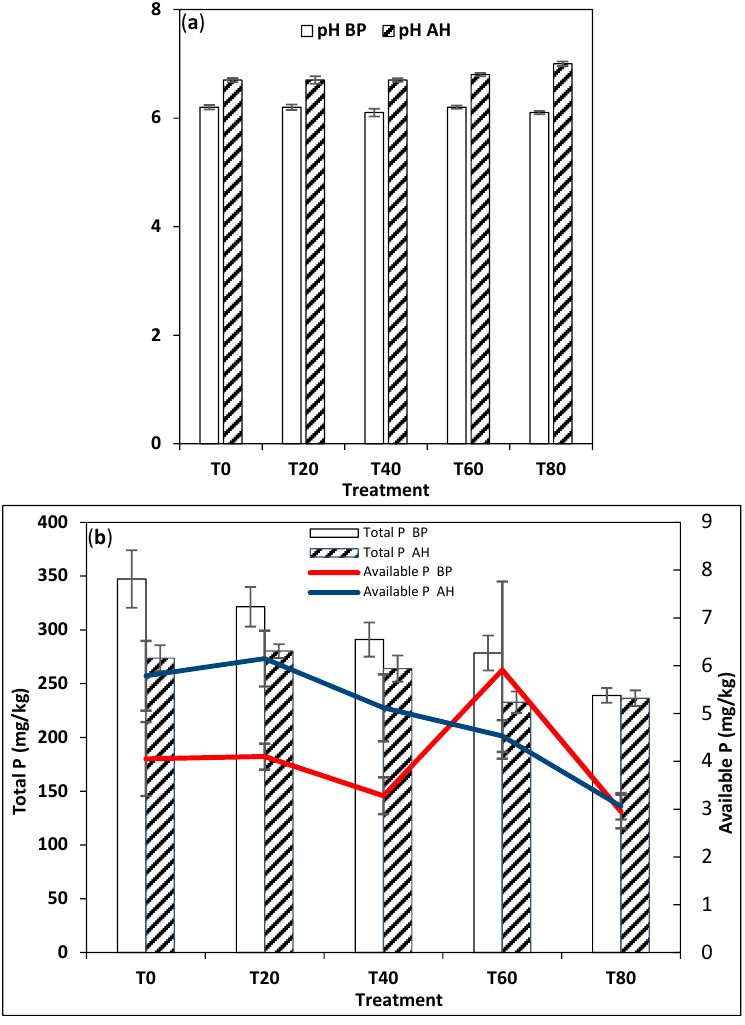
Figure 3. Effects of fertilizer treatments on ( a ) pH and ( b ) total P and available P measured before planting (BP) and after harvest (AH) of Solanum macrocarpon cultivated on dry savanna soils.